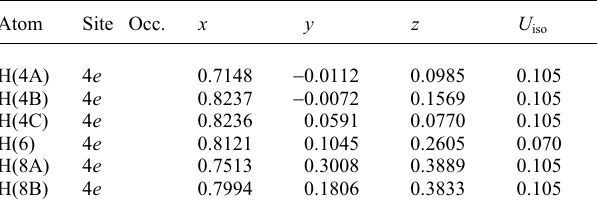
Table 2. Atomic coordinates and displacement parameters (in Å 2 )